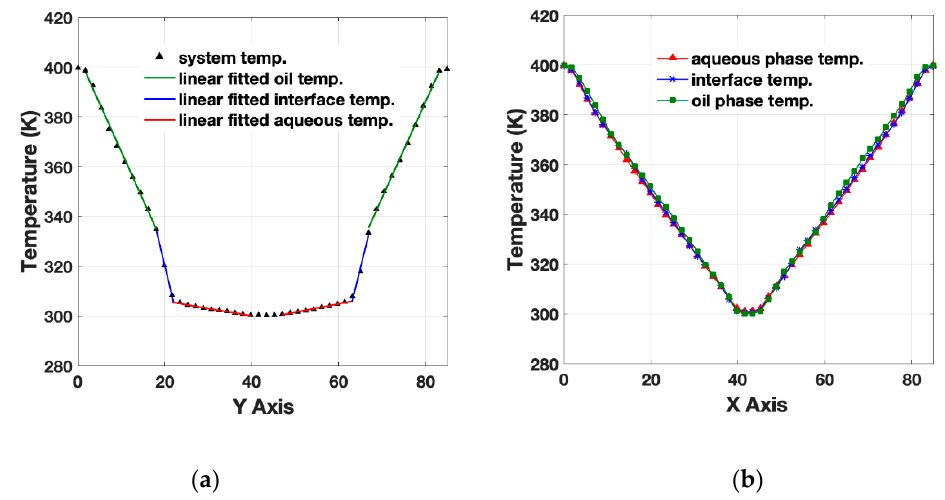
Figure 9. Temperature profiles of the n-hexane and water system, corresponding to case 8 at Table 3: ( a ) along the Y direction when the heat is transferred perpendicular to the interfaces shown in Figure 2a, ( b ) along the X direction when the heat is transferred parallel to the interfaces as shown in Figure 2b. Table 3. Ratios of the parallel interfacial thermal conductivities κ || over perpendicular conductivities ff ective thermal κ ⊥ , water thermal conductivities κ κ H2O , the oil thermal conductivities oil , and e conductivities κ e ff .